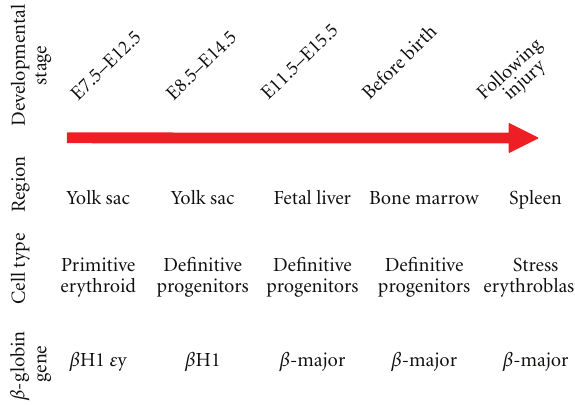
Figure 2: Distinct waves of erythroid cell generation in the mouse. Di ff erent populations of erythroid cells are generated during distinct embryonic periods in the bone marrow and following injury in the mouse. These populations vary according to their site of origin, embryonic stage of production, morphology, and β -globin gene expression. E: embryonic day, scored from days following